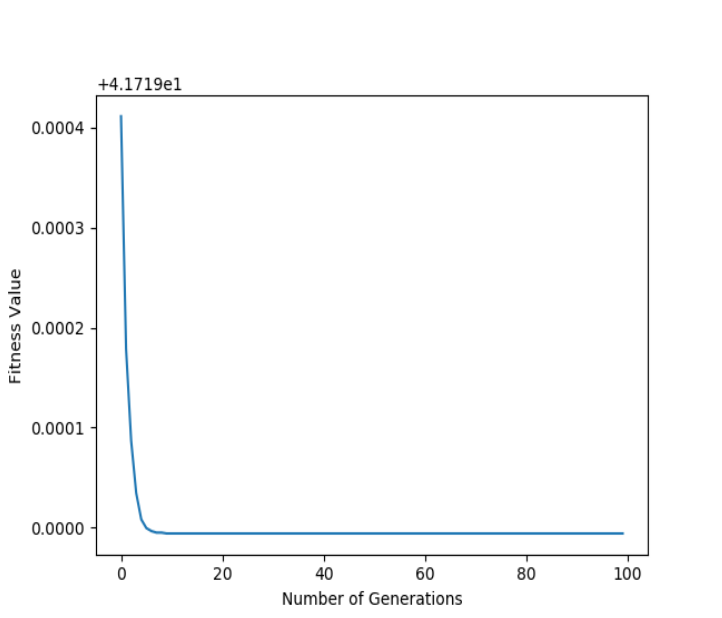
Figure 7. Convergence graph for image-3.